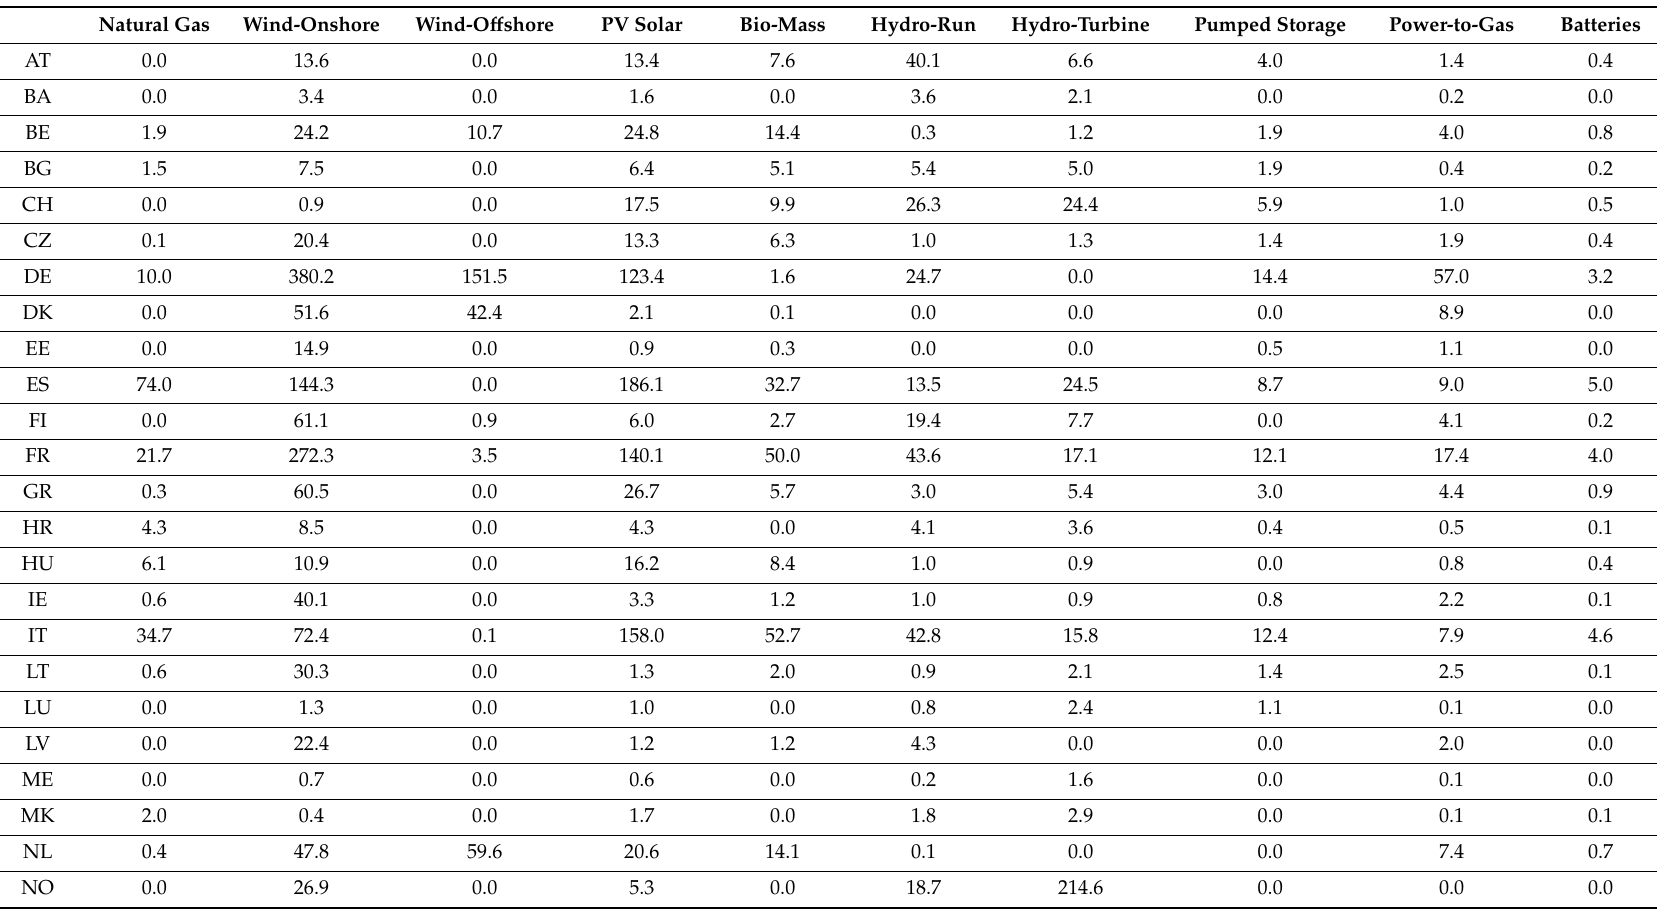
Table A6. Electricity generation in TWh, scenario year 2050 in the Lower Connectivity scenario. Source: own calculations. Natural Gas Wind-Onshore Wind-O ff shore PV Solar Bio-Mass Hydro-Run Hydro-Turbine Pumped Storage Power-to-Gas